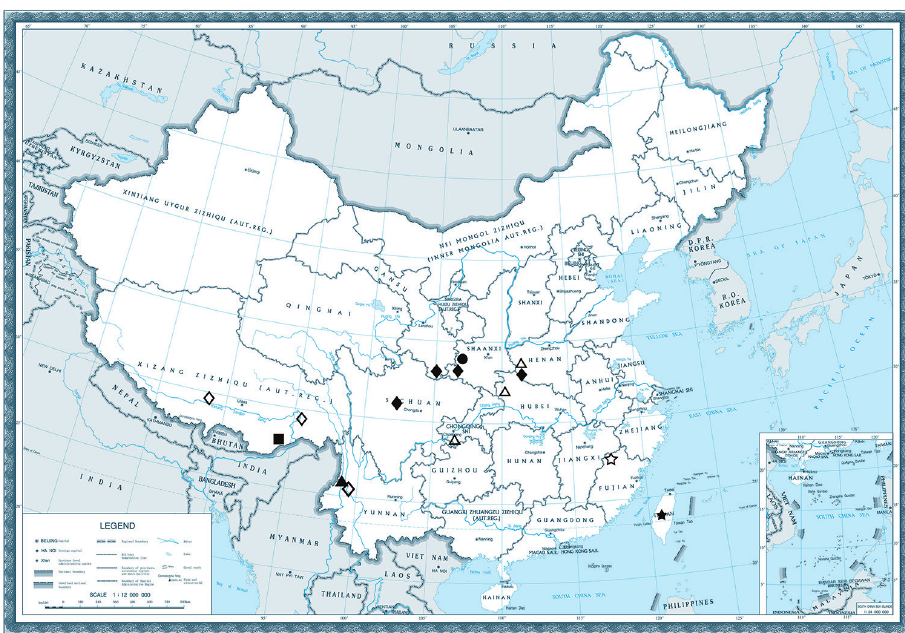
Figure 1. Distribution of Heterosmylus in China.  = H. curvagradatus  = H. flavidus  = H. limulus  = H. primus  = H. processus sp. n.  = H. shennonganus  = H. wolonganus  = H. yunnanus fined pterostigma and hyaline and colourless membrane) is found in Shaanxi near the Qinling Mountains.